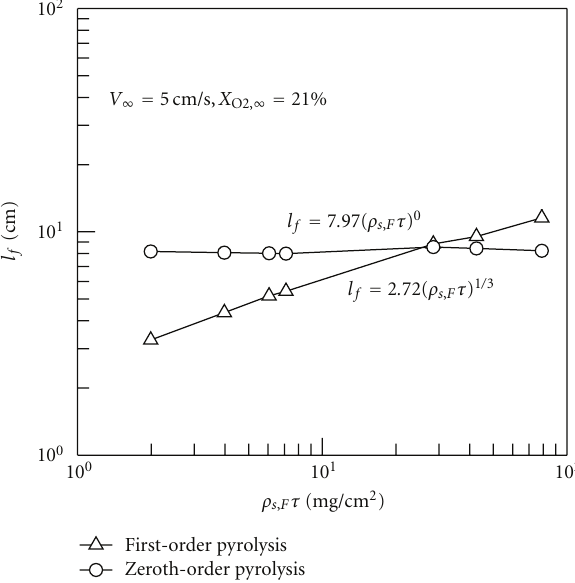
Figure 8: Thickness e ff ect on flame length for both pyrolysis